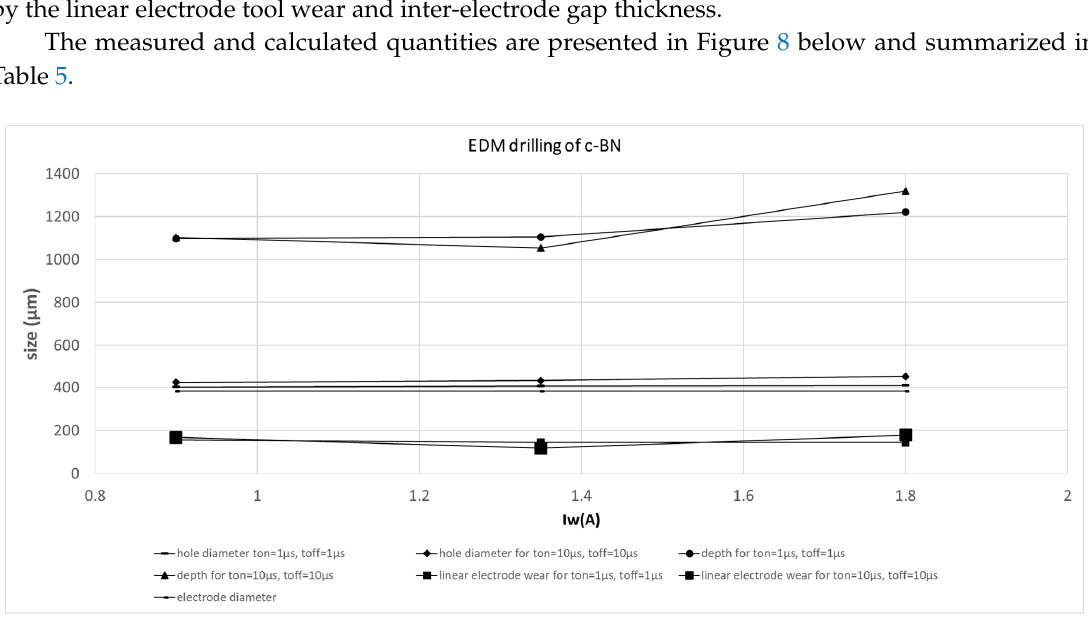
Figure 8. Results of electrodischarge drilling with the use of a tungsten electrode tool in a c-BN sample for various t on and t o ff